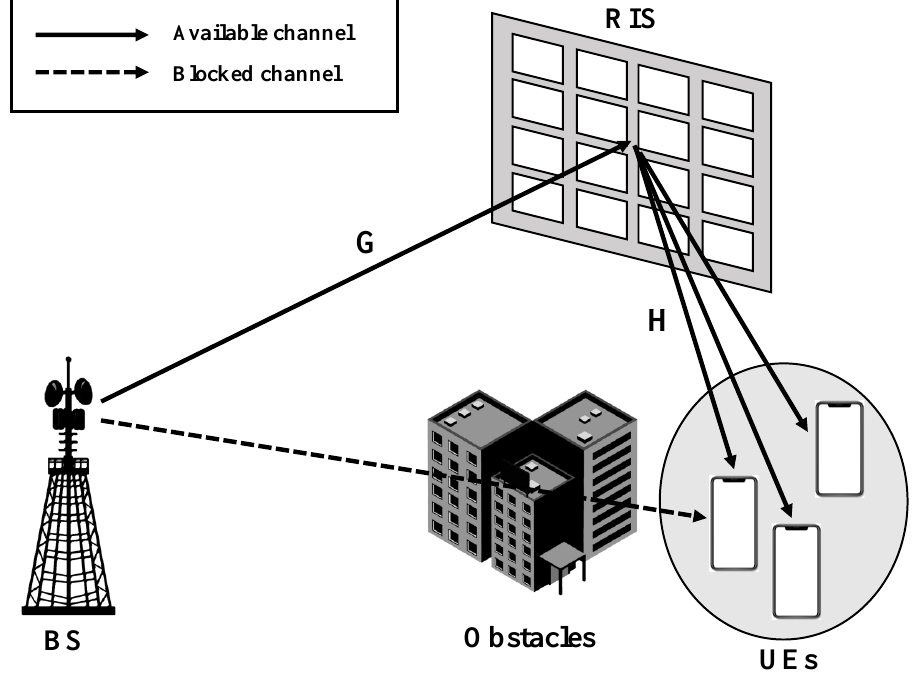
Figure 1. RIS-assisted MU-MIMO downlink